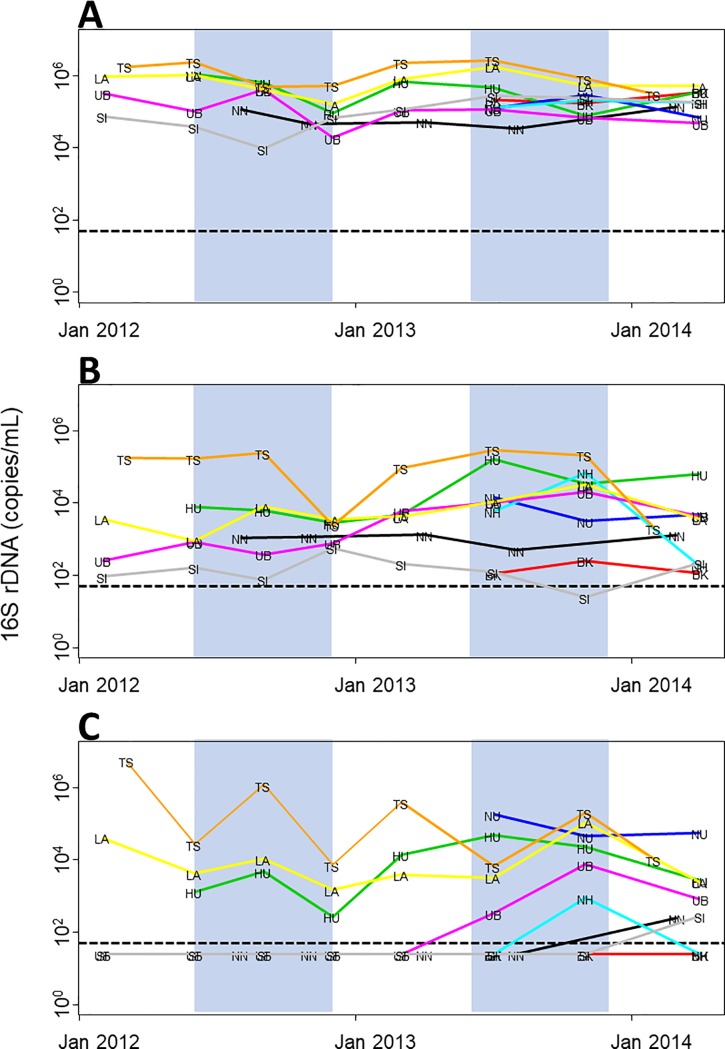
Seasonal dynamics of cyanobacteria.16S rDNA densities during the study period for (A) Synechococcus spp., (B) Microcystis aeruginosa, and (C) Dolichospermum spp. Shaded areas represent the wet season (May–October) as defined in text. Dashed horizontal lines represent detection limits.